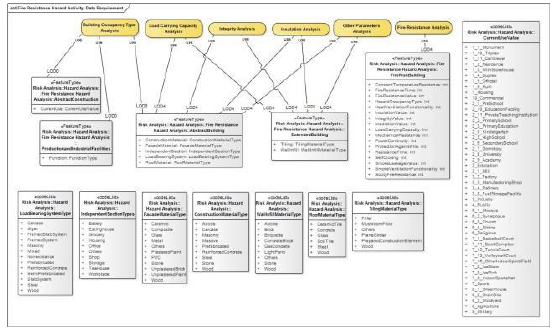
Figure 8: Geo-information requirements diagram of